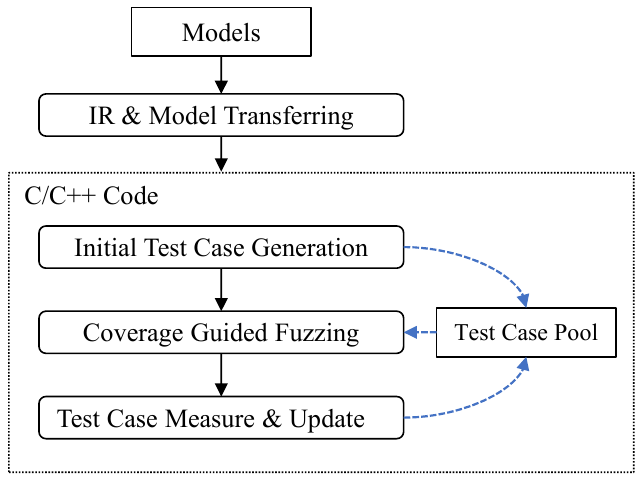
Figure 2. Overall Workflow